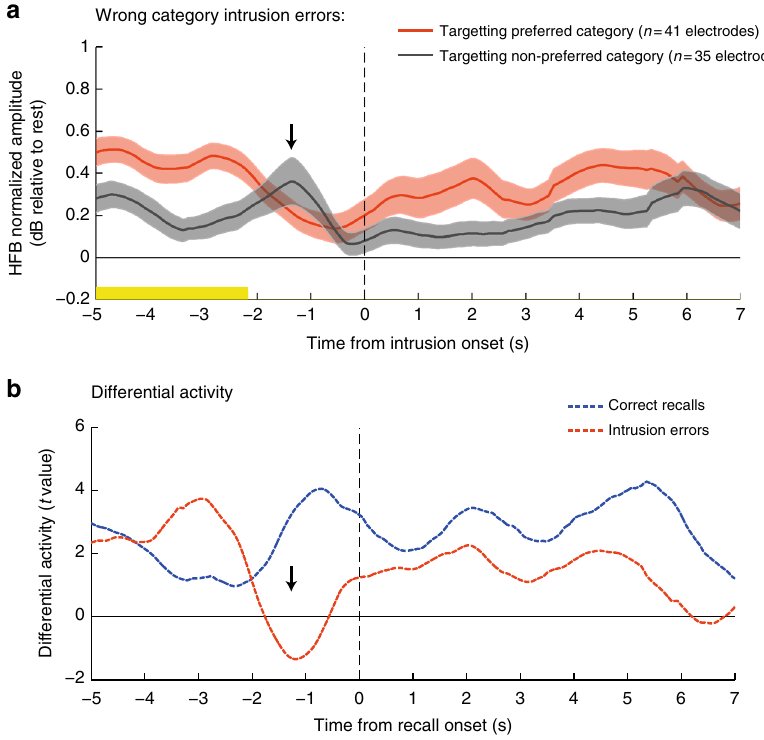
Fig. 6 Recall errors: intrusion of items from the non-designated category. a HFB activity in category selective electrodes during events in which an item from the non-designated category was erroneously retrieved (i.e., extra-category intrusion). Intrusions that occurred when the preferred category was targeted are plotted in red; intrusions that occurred when the non-preferred category was targeted are plotted in gray. Note that 2 s before the onset of an intrusion error, the enhancement of the preferred (targeted-) category was transiently reduced until the opposed category has taken the lead. Shaded areas represent SEM. Signi fi cant time bins are indicated in yellow ( p < 0.05, cluster-based correction using Monte Carlo simulation). b Time-course of consecutive two sample t -tests contrasting preferred vs. non-preferred categories during intrusion errors (blue) and during correct recollections (red; taken from Fig. 5). Note the transient decrease in t -values (black arrow) re fl ecting both baseline shift reduction and a transient reactivation of